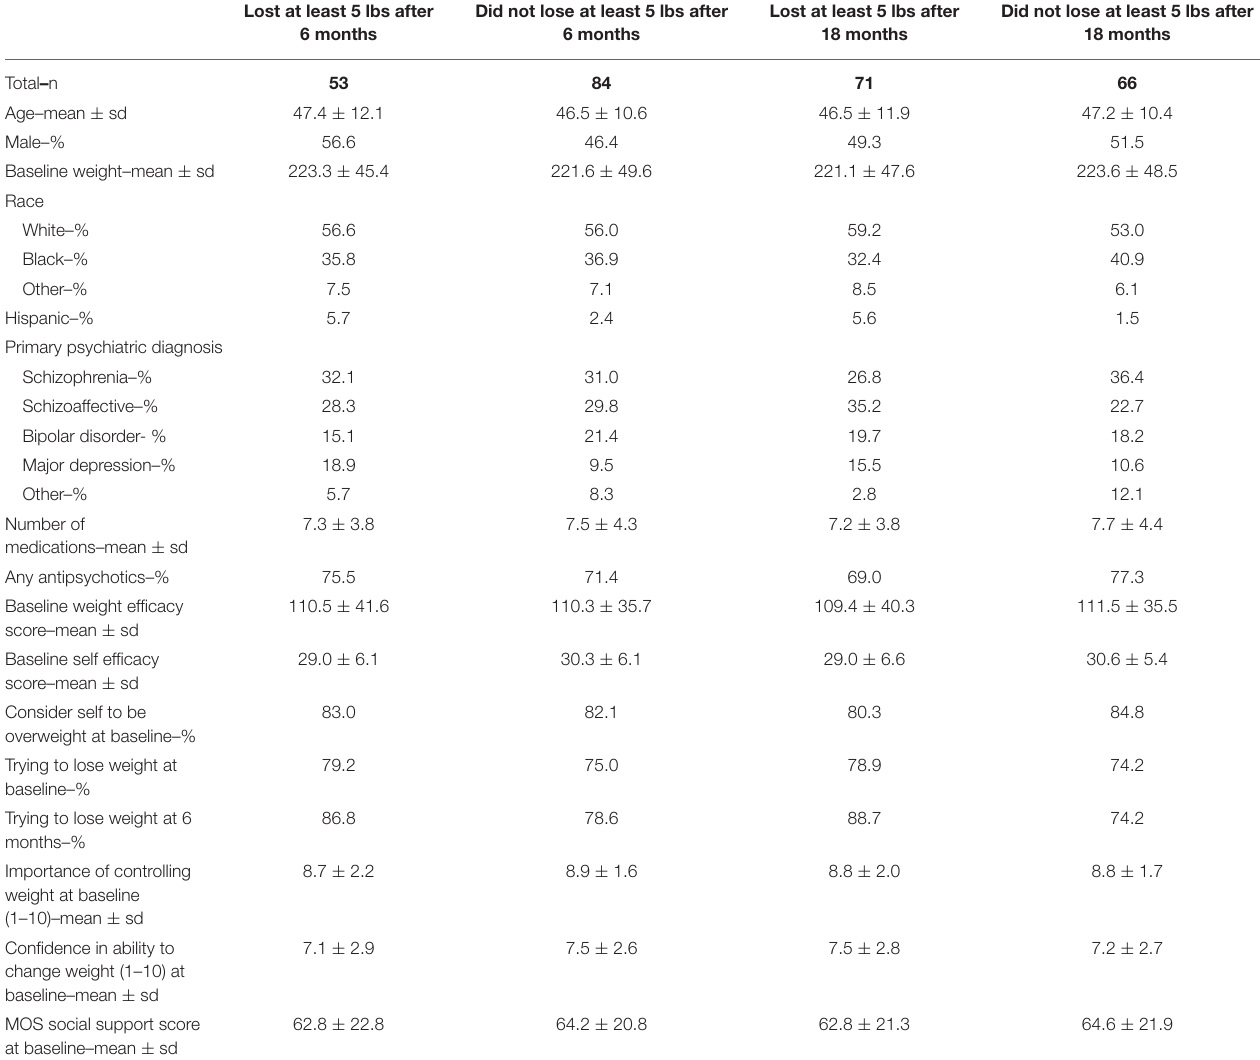
TABLE 1 | Participant characteristics by weight loss